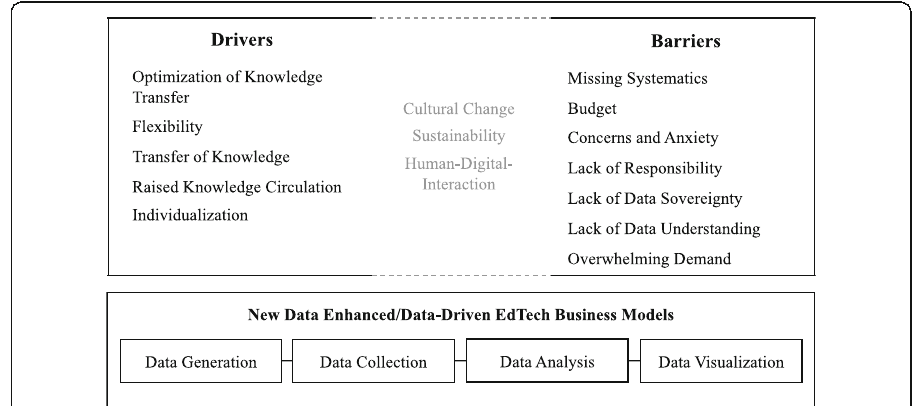
Fig. 6 Drivers and barriers for the development/implementation of AI-based